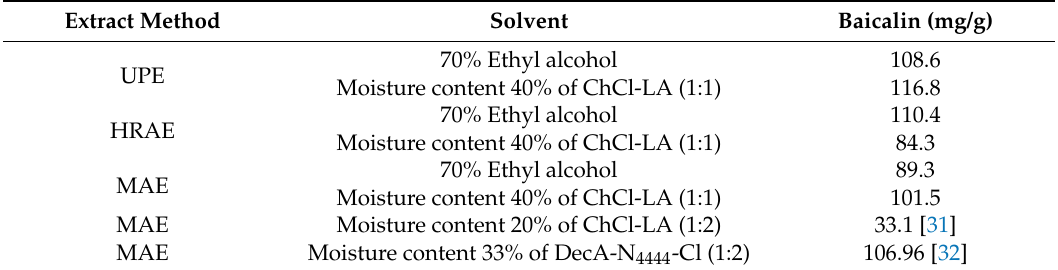
Table 6. Extraction contents of the baicalin using various extraction